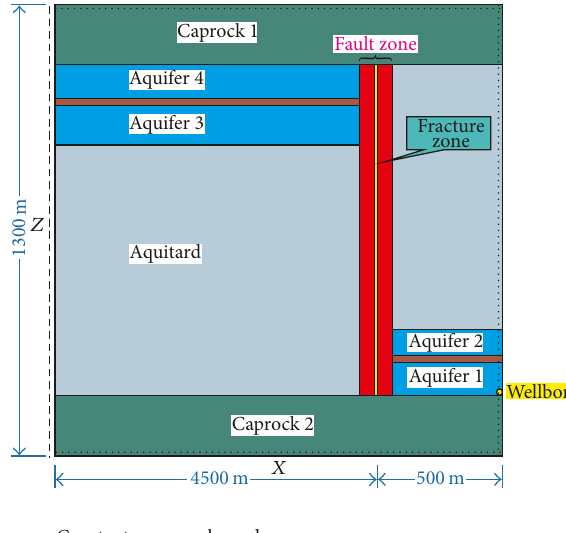
Figure 1: Concept model of CO 2 leakage along the fracture zone developed in the middle of a fault area which offsets and connects two sets of aquifers, the deep Aquifers 1 and 2 and shallow Aquifers 3 and 4. Open fractures of different apertures may grow inside the fracture zone and work as a fast pathway for CO 2 leakage. A horizontal well of 2 m length is drilled at the right and bottom side of Aquifer 1 for 5 years’ CO 2